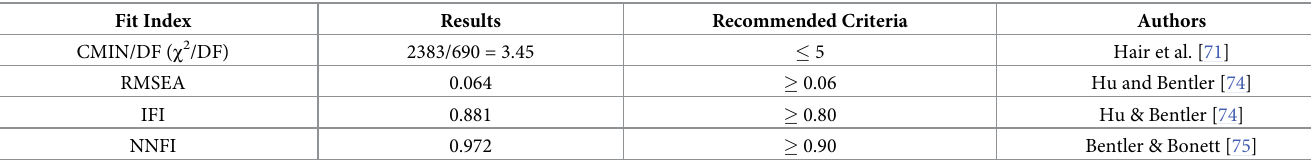
Table 6. Goodness of fit indices.